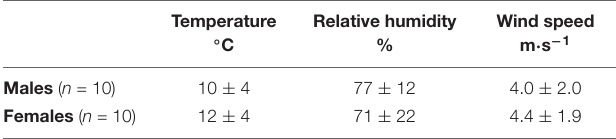
TABLE 2 | Ambient conditions during cycling